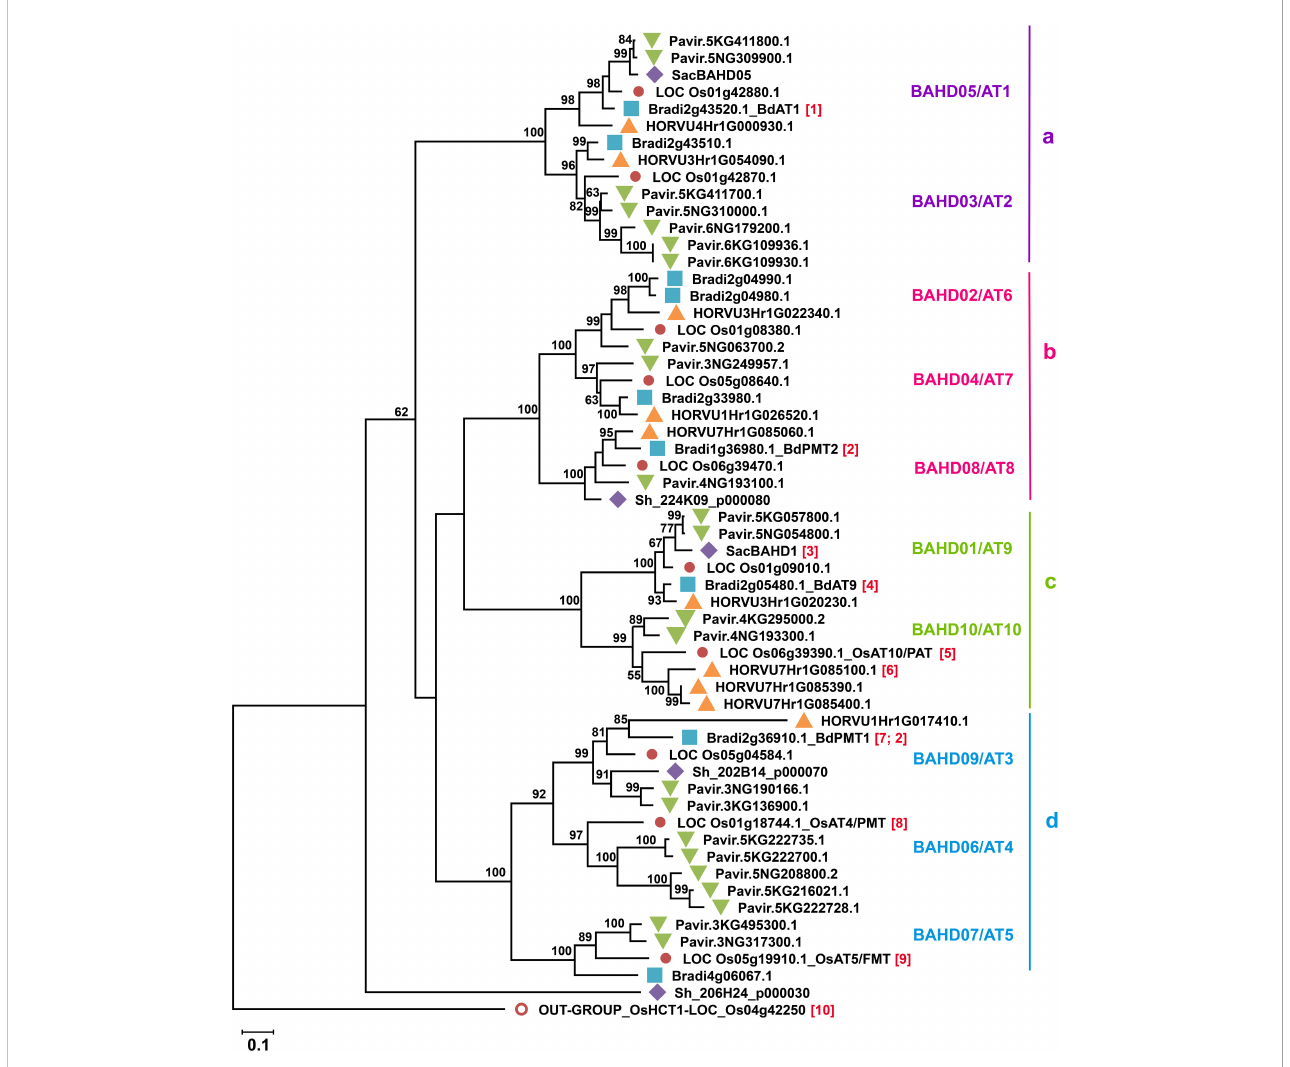
FIGURE 4 Phylogenetic reconstruction of Mitchell subclade of grass BAHD acyltransferases. Phylogenetic tree was generated by maximum likelihood method (Jones et al., 1992) using Mega X software (Kumar et al., 2018) after multiple sequence alignment by MUSCLE (3.8). All sequences of rice genes (Os) originally identi fi ed in Mitchell subclade (Bartley et al., 2013; Molinari et al., 2013) and their orthologs in Brachypodium distachyon v3.1 (Bradi), Saccharum (Sh; sequences from (de Souza et al., 2019), Hordeum vulgare (HORVU) and Panicum virgatum v5 (Pavir) are included. The rice HCT gene OsHCT1 Kim et al. (2012) [10] was used as an outgroup. The division of proteins into sub-groups (a-d) as in Karlen et al. (2016) is indicated on the right. Proteins that are functionally characterized are as follows: [1] Buana fi na et al. (2016), [2] (Sibout et al., 2016), [3] de Souza et al. (2019) [4] de Souza et al. (2018) [5] Bartley et al. (2013) [6] Houston et al. (2020), [7] Petrik et al. (2014), [8] Withers et al. (2012), [9] Karlen et al. (2016). Where assigned, enzyme activities are PMT p -Coumaryl CoA Monolignol Transferase, FMT Feruloyl CoA Monolignol Transferase, PAT p -Coumaryl CoA Arabinoxylan Transferase. Numbers on tree nodes are percentage bootstrap support; values <50 not shown. Scale bar indicates branch lengths measured in the number of substitutions per